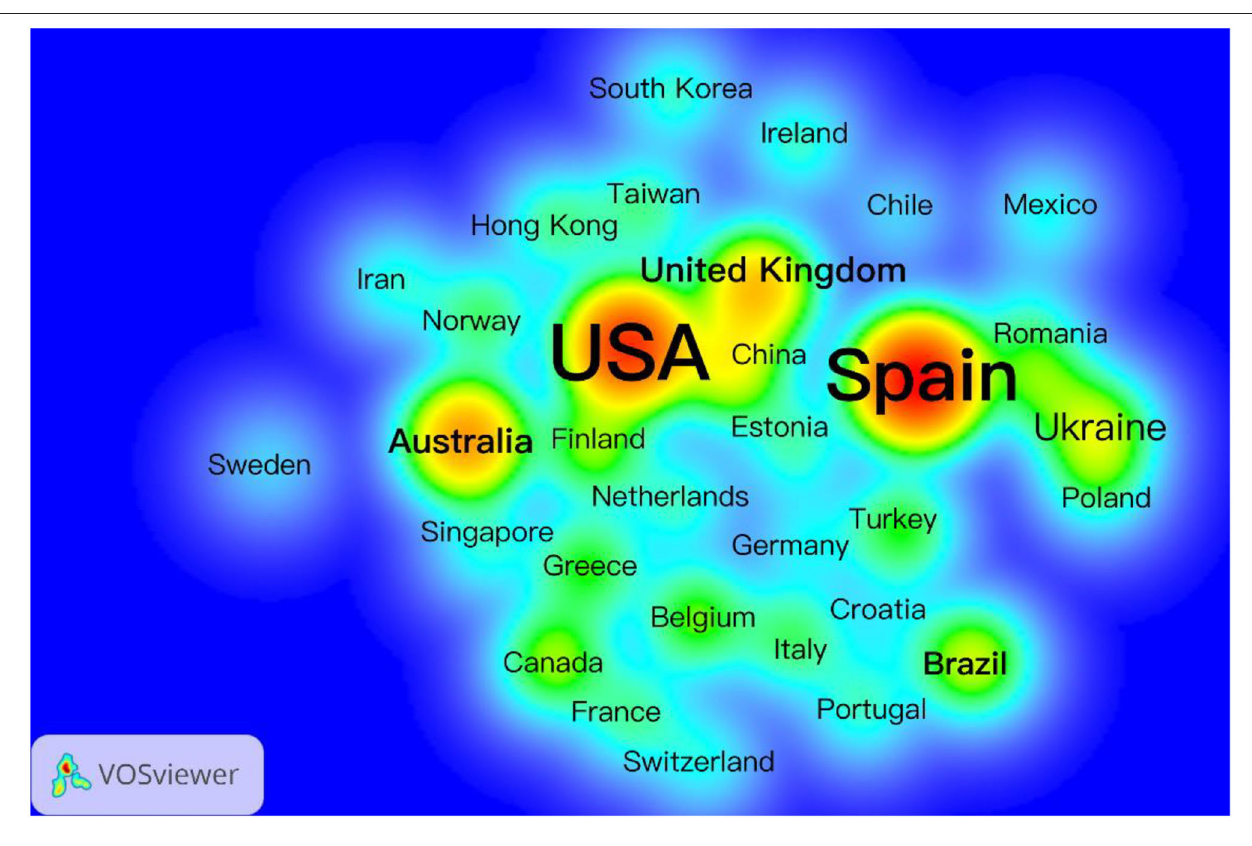
FIGURE 3 | Country/region publication density